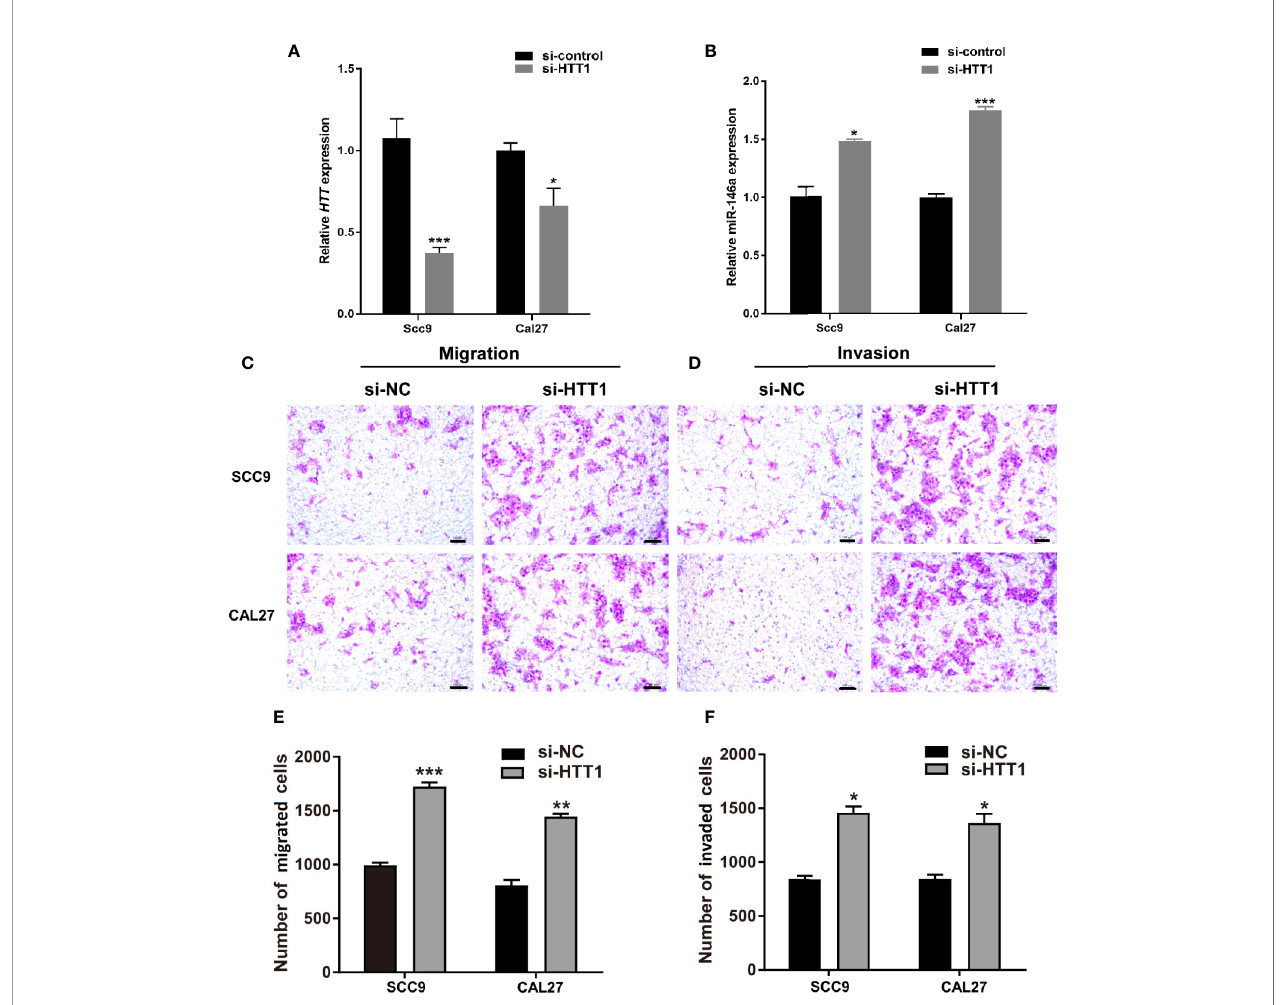
FIGURE 6 | HTT inhibits the migration and invasion of OSCC cell lines. (A) HTT expression pattern in OSCC cell lines transfected with HTT si-RNA. (B) miR-146a expression pattern in OSCC cells transfected with HTT si-RNA. Representative microscopic images of (C) OSCC cell migration, and (D) OSCC cell invasion assays. Quantitative analysis of (E) migrated, and (F) invaded cells ( F ). Data are presented as mean ± SD form three independent experiments in triplicate. Signi fi cant effect of treatment compared to a si-NC group, *P < 0.05, **P < 0.01, and ***P < 0.001. NC, negative